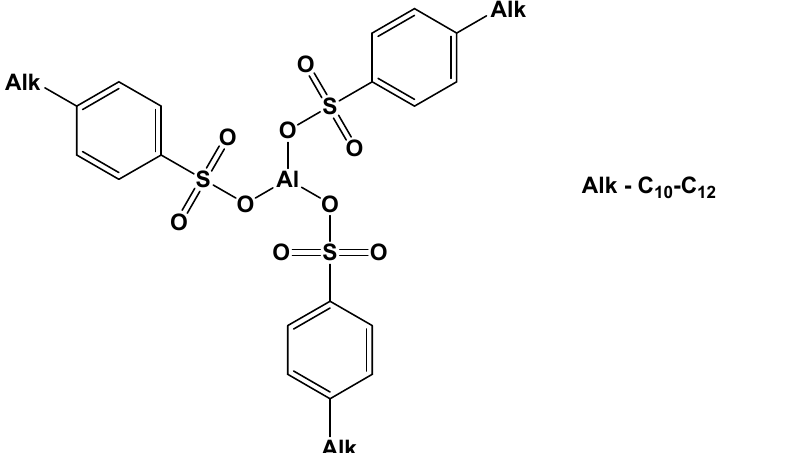
Figure 5. The proposed structural formula of Al ABSA3.2. Upgrading performance of the obtained catalysts.